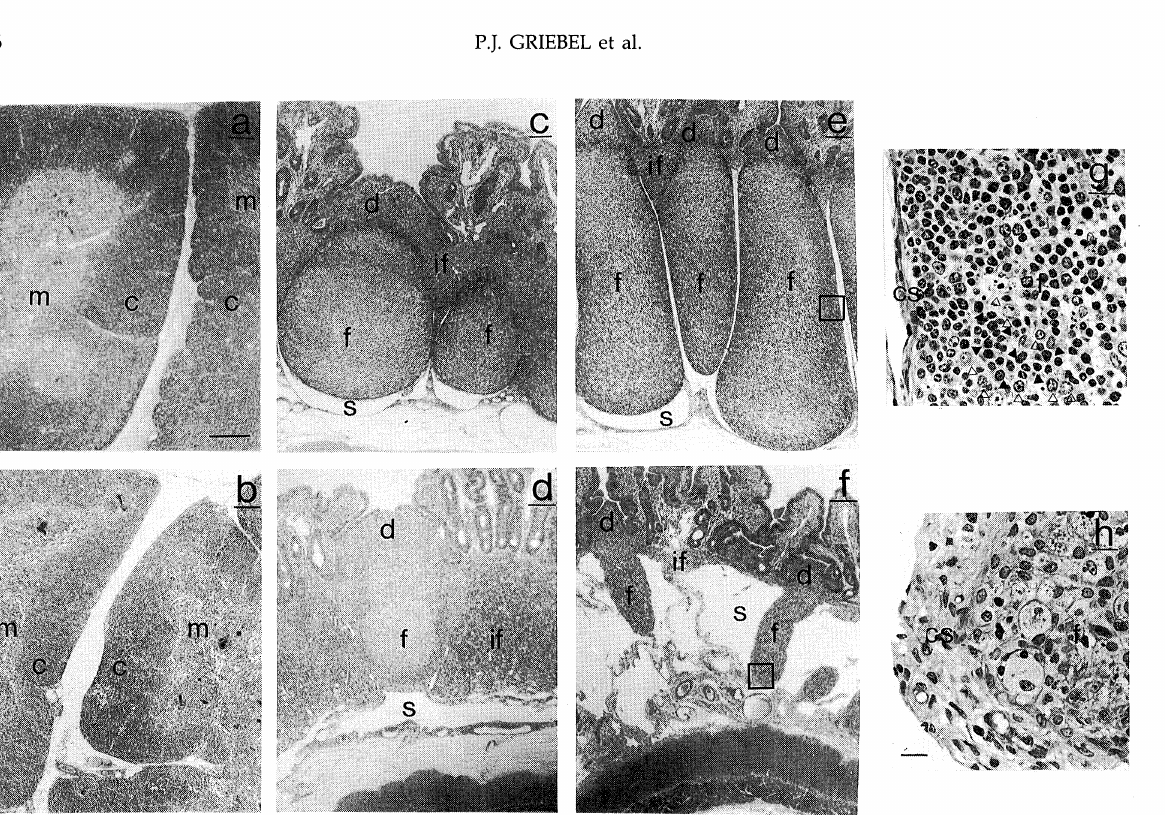
FIGURE 1. The histology of the thymus, jejunal PP, and ileal PP are compared for age-matched untreated (control) lambs and lambs treated for 7 days with 2 mg dexamethasone/kg BW (dex). Thymus: a (control) and b (dex) with the cortex (c) and medulla (m) indicated. Jejunal PP: c (control) and d (dex) with the lymphoid follicles (f), dome region (d), interfollicular area (if), and lymphatic sinuses (s) indicated. Ileal PP: e (control) and f (dex) with lymphoid follicles (f), dome region (d), interfollicular area (if), and lymphatic sinuses (s) indicated. Ileal PP follicle: g (control) and h (dex) with the follicular capsule (cs) and "nests" of lymphocytes (closed triangles) distributed among nonlymphoid stromal cells (open triangles) indicated. Magnification: a-f (bar [in a] 300 m); g and h (bar [in h] 20